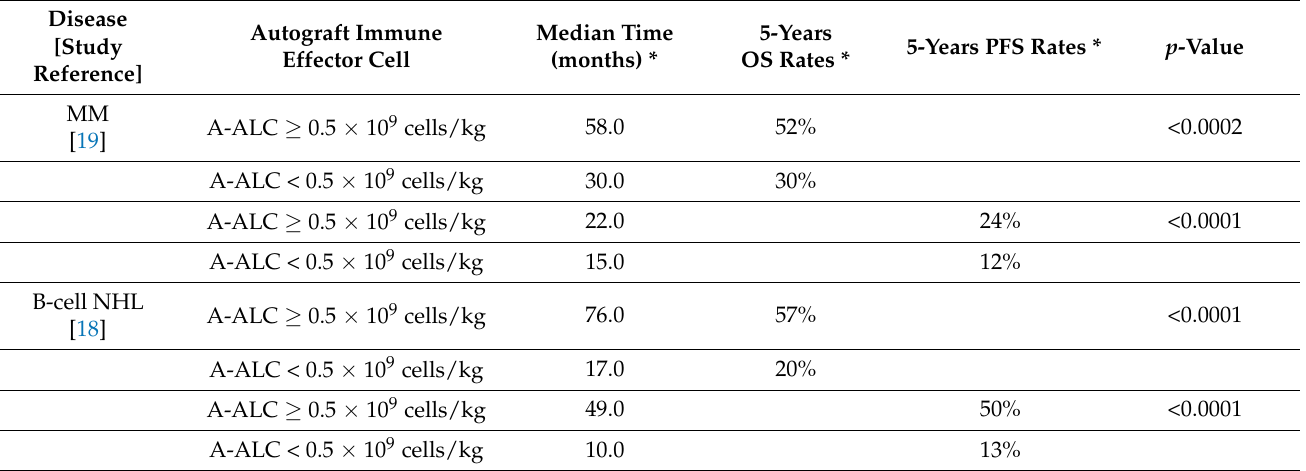
Table 1. Clinical outcomes post-autologous stem cell transplantation based on the infusion of autograft-absolute lymphocyte